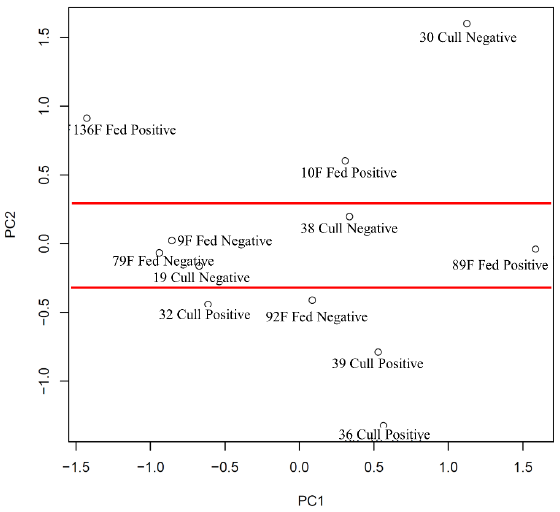
Figure 3. Principal component analysis (PCA) plot generated from sub-iliac lymph nodes collected from feedlot and cull dairy cattle at slaughter that were either Salmonella positive or negative. The kinome profiles of these animals were plotted by PCA. Between the red lines are all but one of the negative cows. SD% of PC1 = 18.21%; SD of PC2 = 15.47%. Table 5. The top 12 KEGG pathways in the sub-iliac lymph nodes collected from feedlot and cull dairy cattle. A list of representative pathways was generated utilizing the statistically significant peptides from the comparison and inputting this peptide list into the online STRING database. Presented below are the top 12 pathways. Pathways in bold are involved in the immune response (total immune peptides: 141).